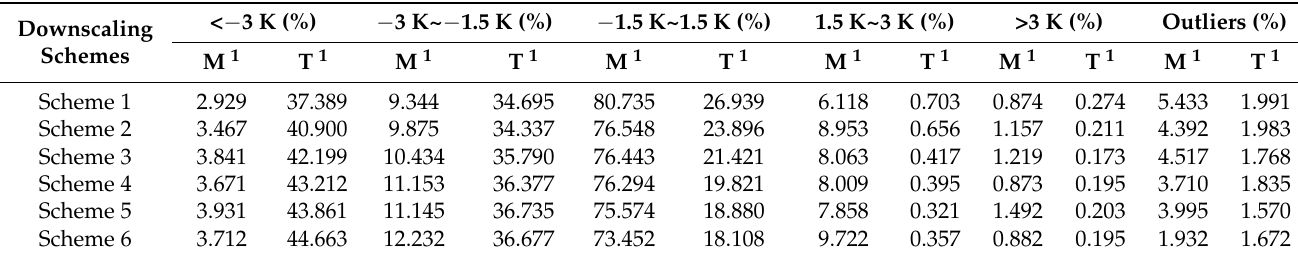
Table 8. Proportional values of LST errors in MFGWML and TsHARP for the six downscaling schemes performed in the entire city of Beijing (excluding water regions).